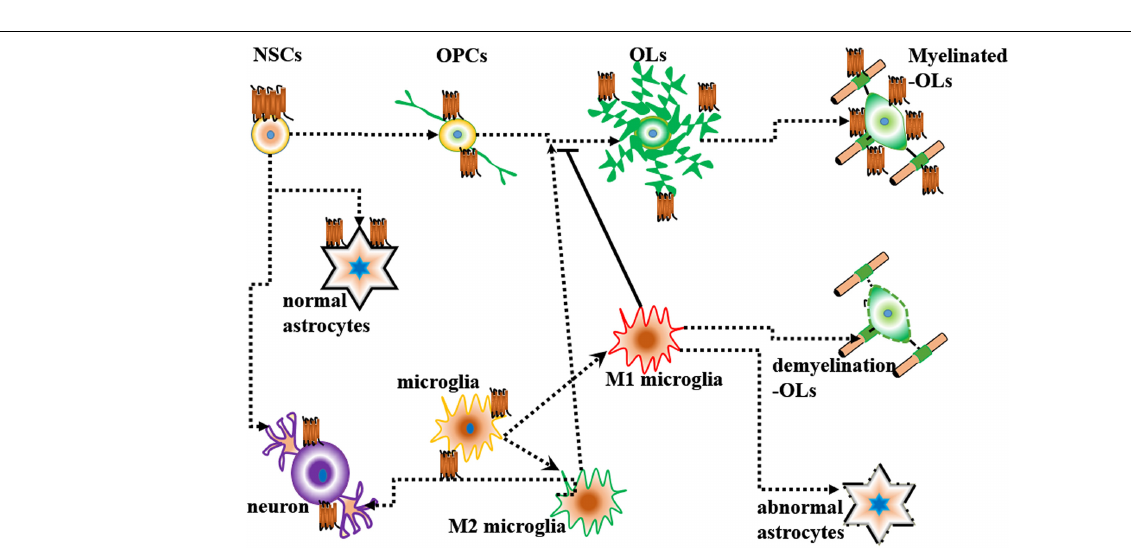
Frontiers in Neuroscience |